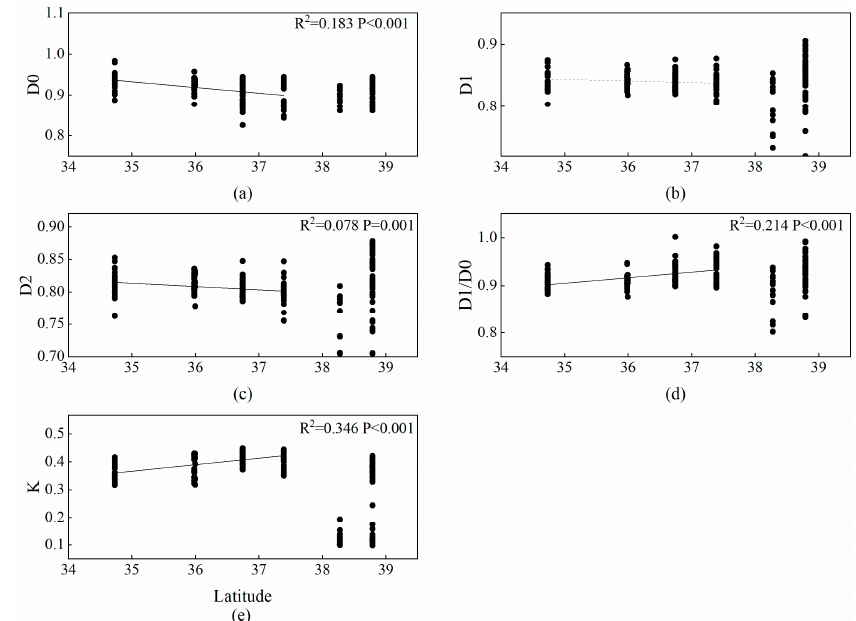
Figure 6. Changes to multifractal dimensions and the erodibility factor with latitude. ( a – e ) show the variation of D0, D1, D2, D1/D0, and K with latitude respectively.